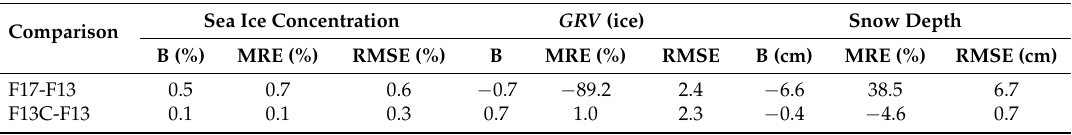
Table 6. Bias (B), mean relative error (MRE) and root mean square error (RMSE) of SIC, GRV, and SD between F13, F17 and F13C in 2007. The SIC, GRV and SD of F13C are derived from F13C TB which